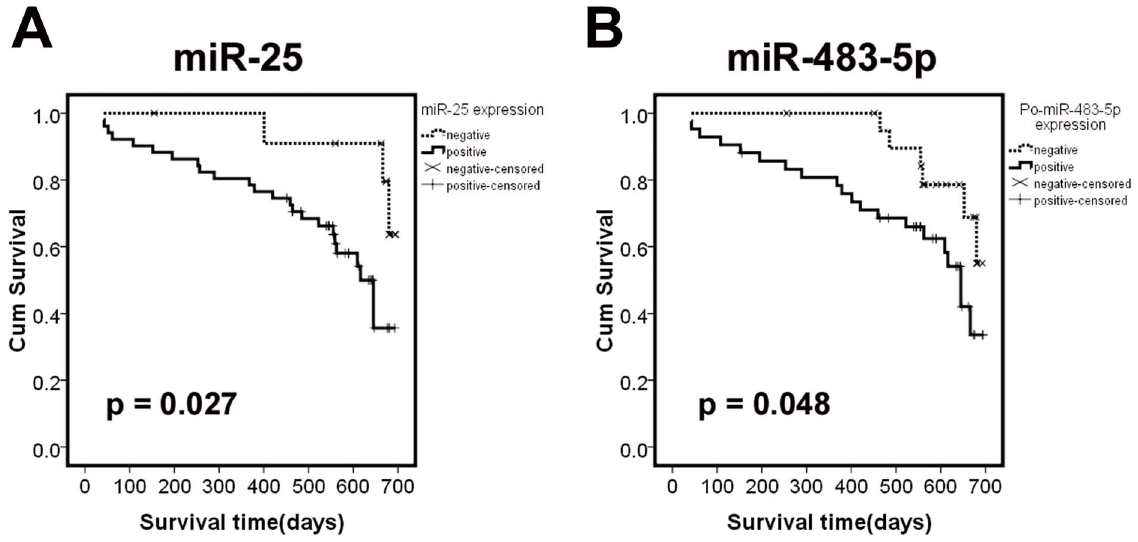
Figure 5. Kaplan–Meier curve estimates the association of miRNAs and the survival of oesophageal squamous cell carcinoma (ESCC) patients. (A)The miR-25 high-level group (greater than the cut-off value; n=51) compared with the miR-25 low-level group (less than the cut-off value; n=12). (B) Postoperative serum miR-483-5p high-level group (greater than the cut-off value; n=48) compared with the miR-483-5p low- level group (less than the cut-off value; n=15). The OS was defined as the interval between surgery and death or the last follow-up examination. Statistical significance was calculated using the log-rank test.